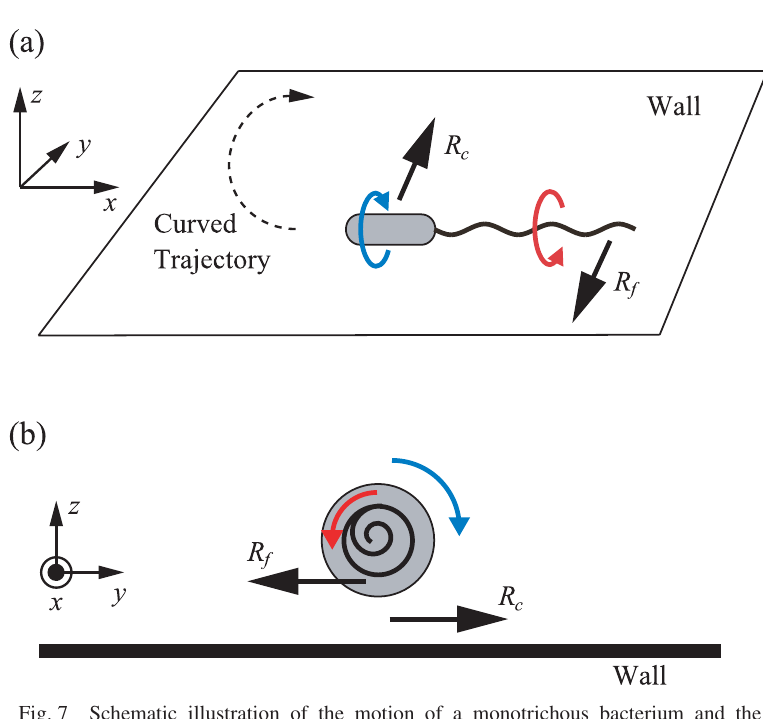
Fig. 7 Schematic illustration of the motion of a monotrichous bacterium and the exerted force by the rigid boundary ((a) overall view, (b) viewed from the flagellum to the cell body). Relationship between these two viewpoints is shown by the coordinate axes. It swims forward by rotating its flagellum in the direction indicated by the red arrow. Due to the balance in torque, the cell body rotates in the opposite direction to the flagellar rotation, indicated by the blue arrow. Their rotations produce resistive forces indicated by the black arrows denoted by R f and R c . Accompanied by the forward motion, the cell draws circular trajectory as indicated by the black curved